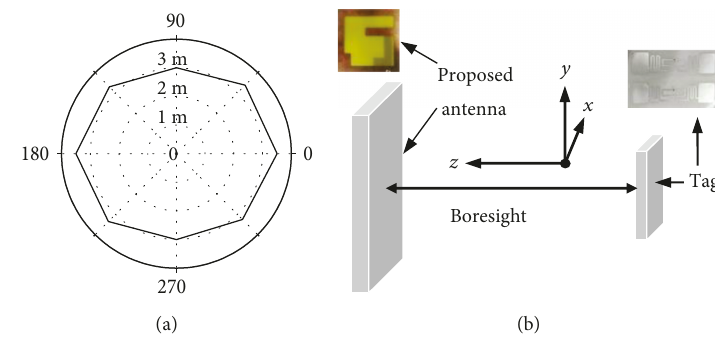
Figure 12: Measured reading ranges for the tag rotating in the ± z -axis.